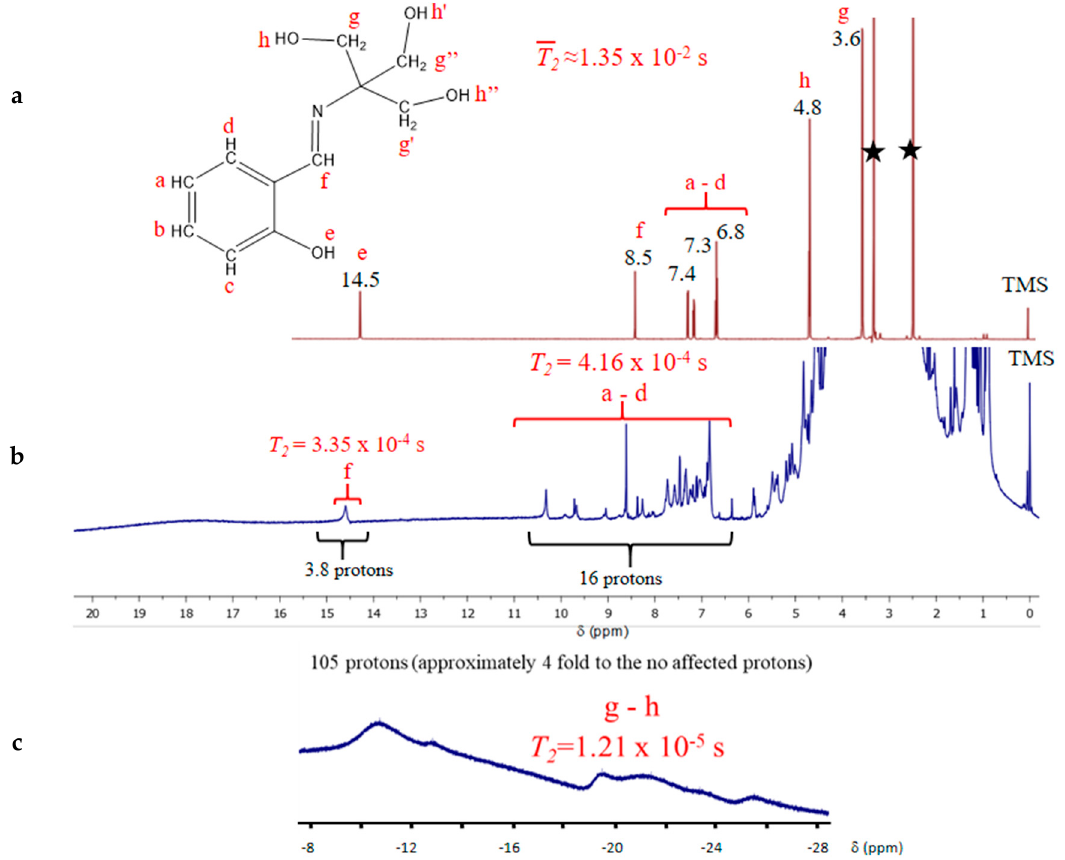
Figure 4. ( a ) 1 H-NMR of H 4 L with proton assignments of the chemical shifts and relaxation times. ( b ) Typical 1 H-NMR for a paramagnetic compound showing magnetic anisotropy and shorter relaxation times (two and up to three-fold higher) generated by the manganese ions coordinated to the H 4 L ligands. ( c ) Isotropic chemical shifts in the negative chemical displacement zone of the spectrum.